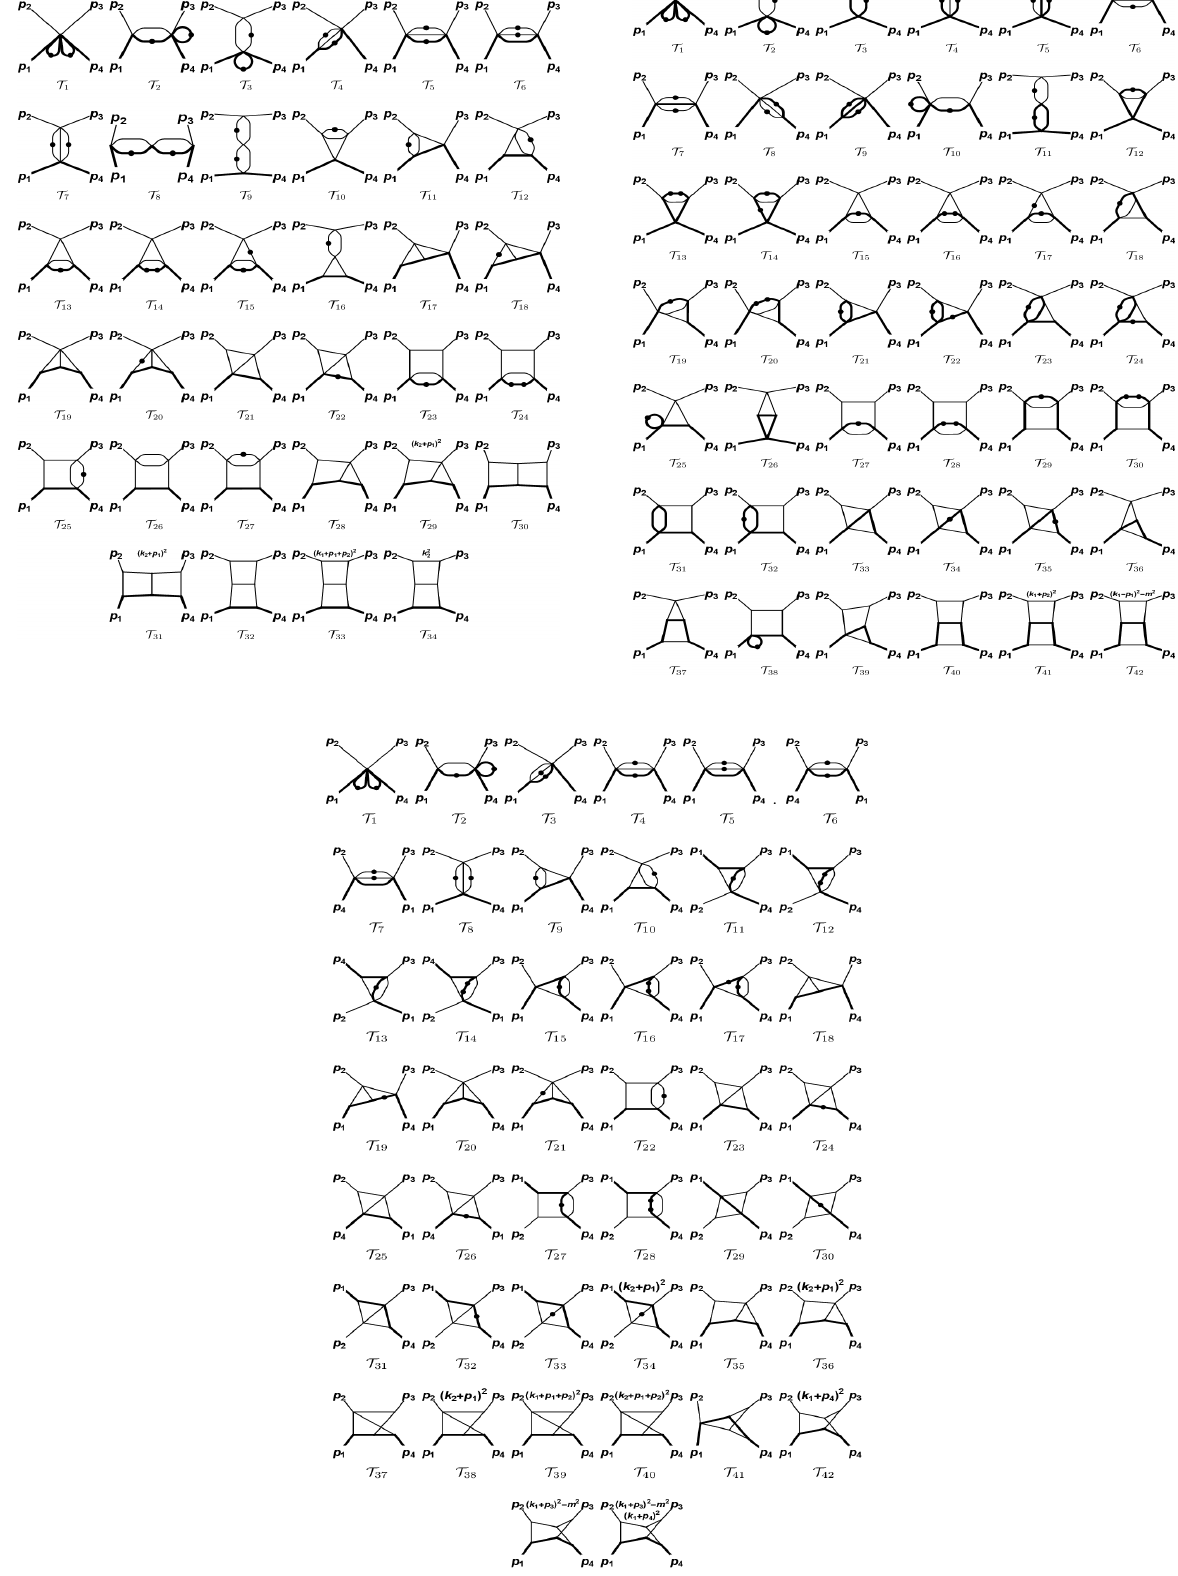
Figure 3. Master Integrals belonging to planar and non-planar topologies for the QED NNLO µ e -scattering